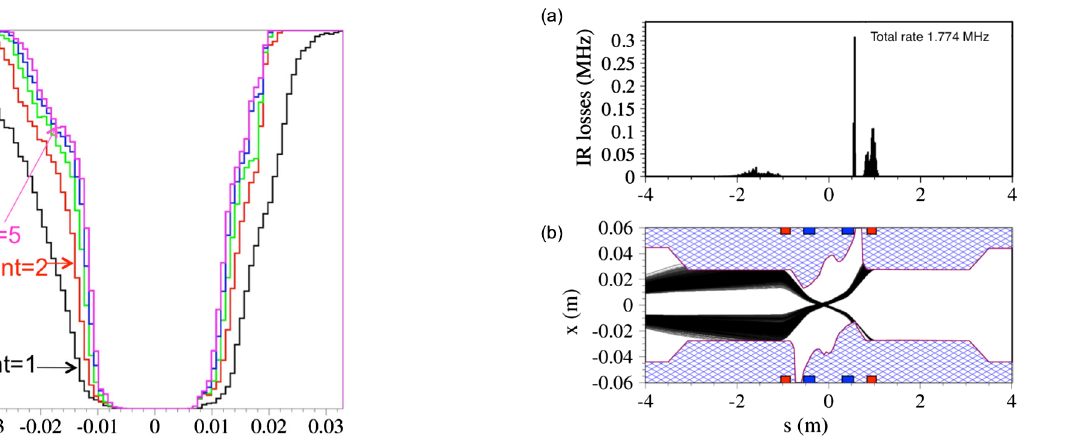
FIG. 4. Loss probability for Touschek particles as a function of their energy deviation dE=E , each color is for a machine turn ( nt ), for the low energy ring SuperB lattice.